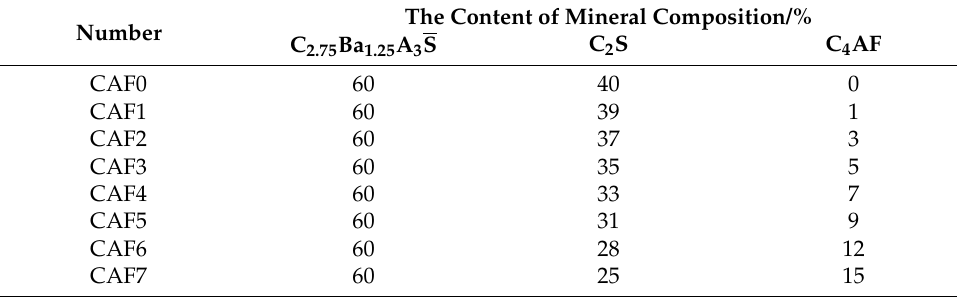
Table 1. Mineral composition of